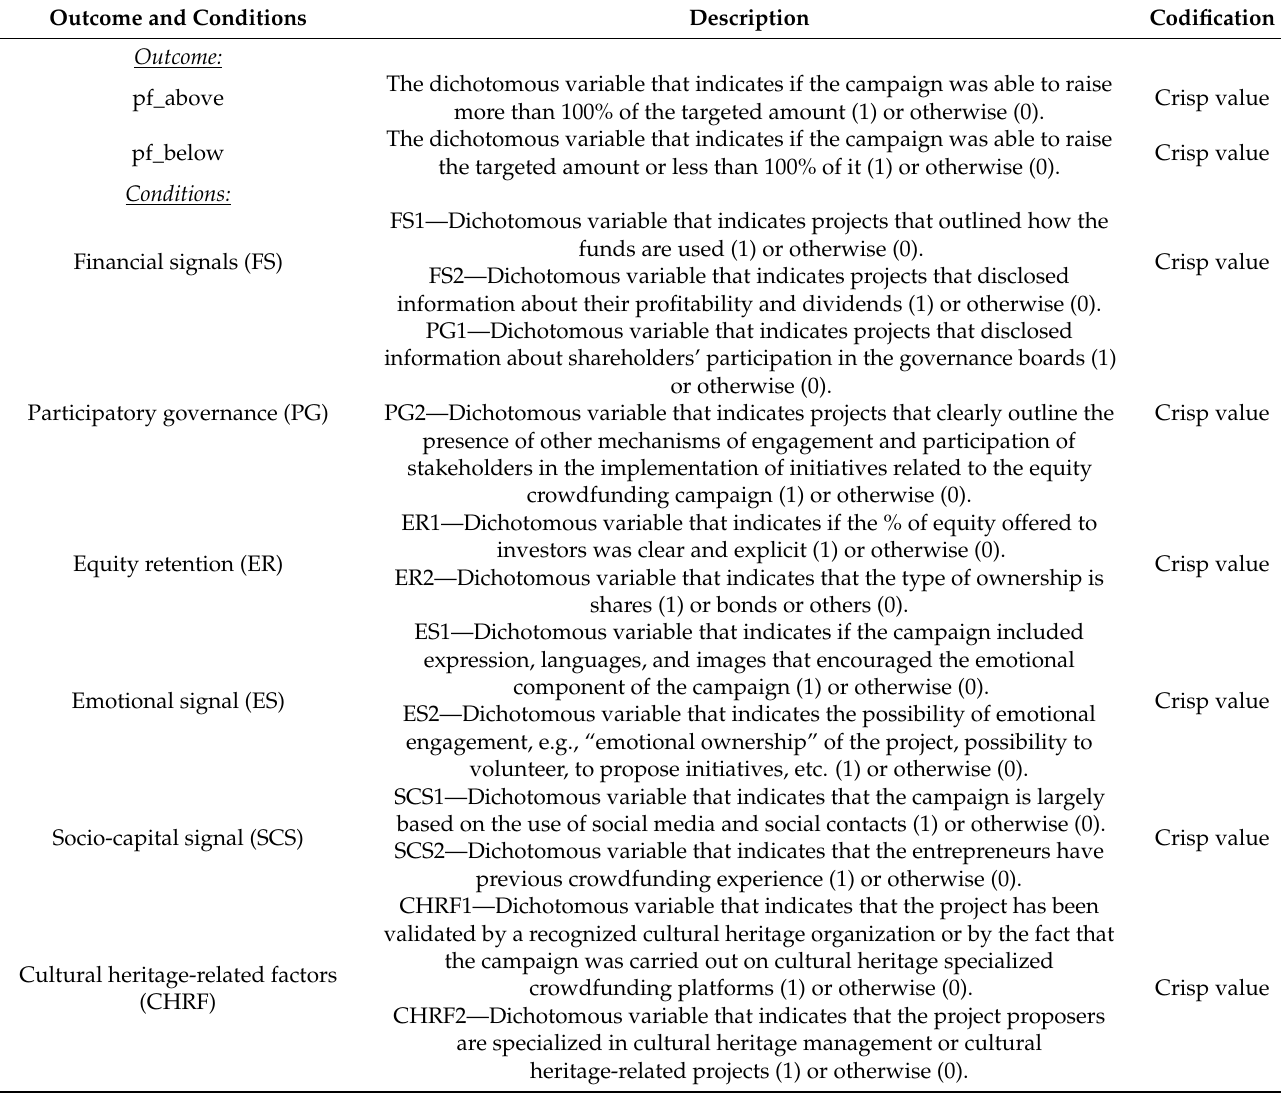
Table 1. Outcome and conditions: Description and